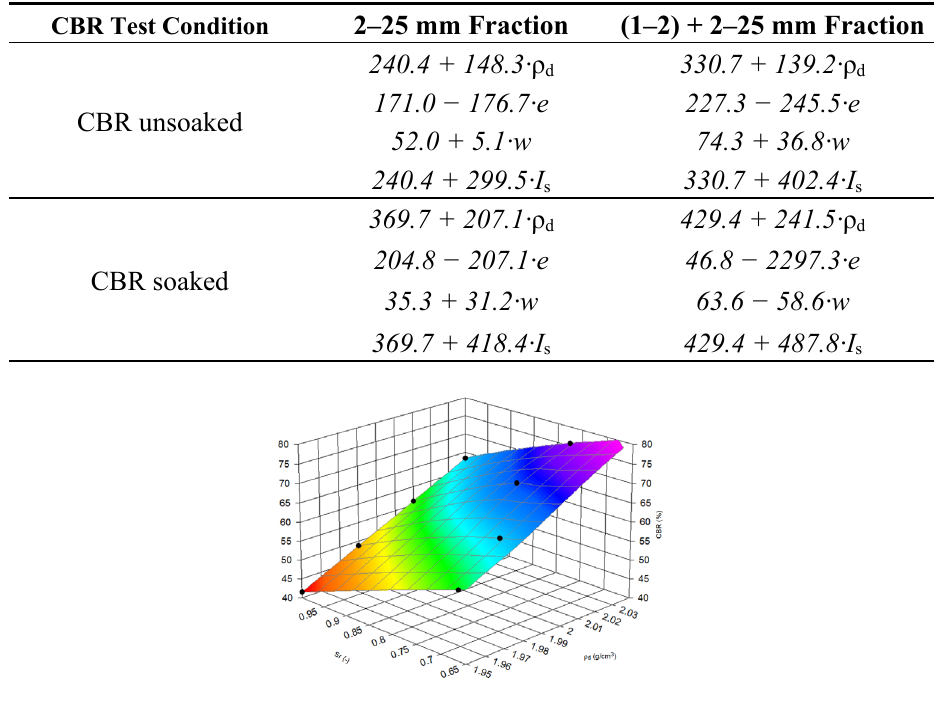
Figure 6. Three-dimensional (3D) view of CBR value dependence from density and saturation ratio (Sr), fraction (1–2) + 2–25 mm.